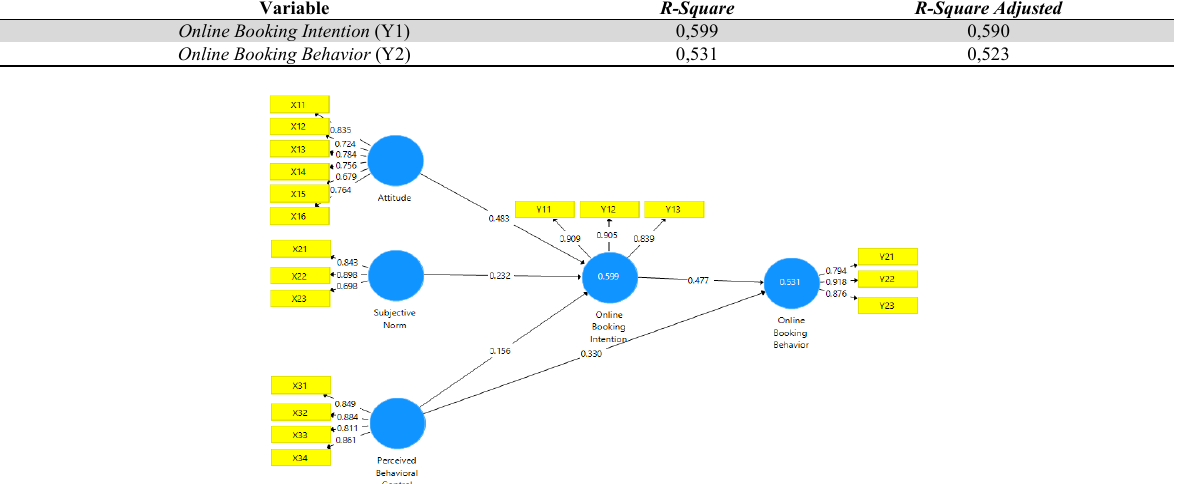
R-square (R 2 ) Value Variable Endogen